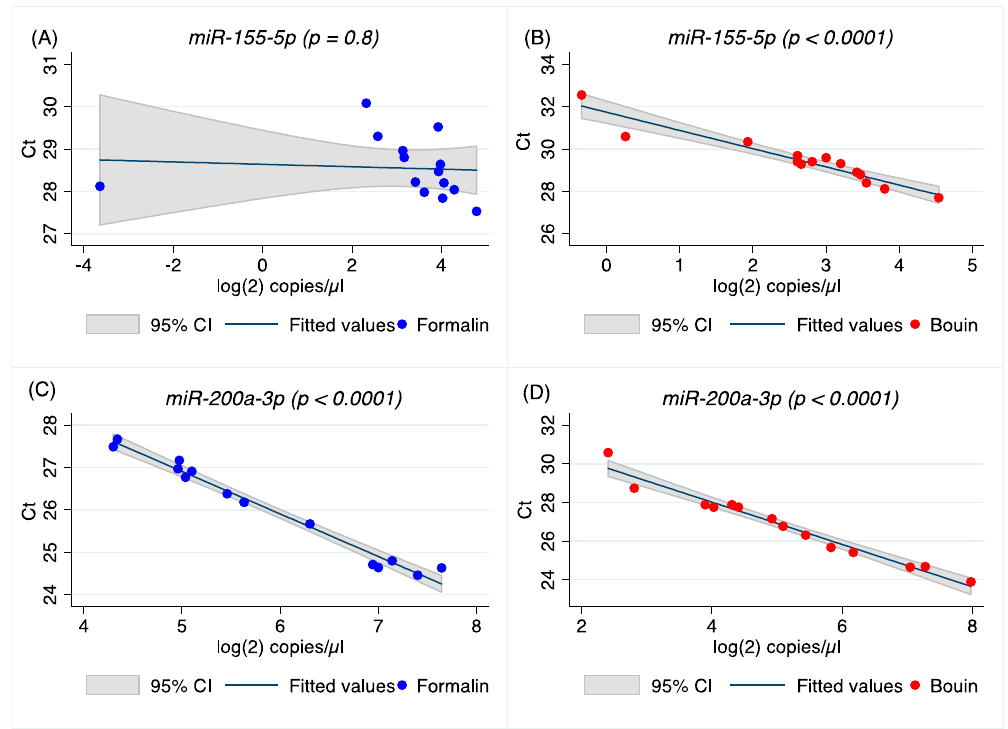
Figure A3. Box plot representing quantitative reverse transcription polymerase chain reaction (RT/ddPCR) of miR-155-5p ( A ), miR-200a-3p ( B ), and miR-429 ( C ) in matched formalin- and Bouin’s- fixed tissues by ddPCR. The box represents the first and third quartiles, intersected by the median, and the whiskers are the range.